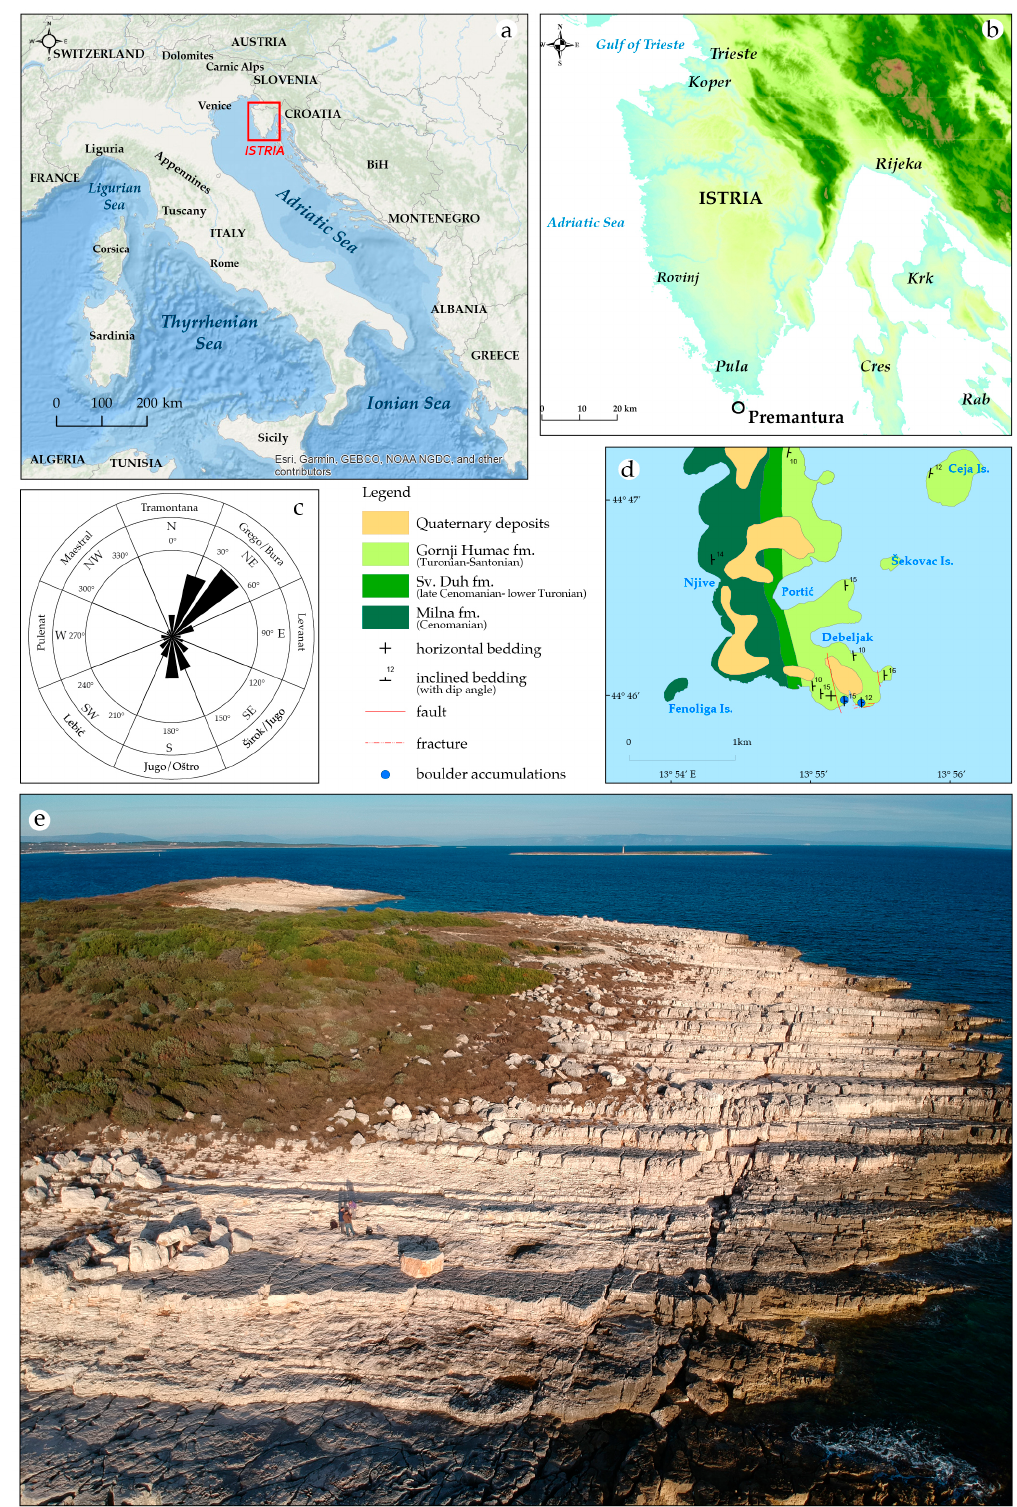
Figure 1. ( a ) Location of the Istrian peninsula, ( b ) location of the Premantura study area, ( c ) Windrose, ( d ) geological map of the South part of the Premantura (Kamenjak) Promontory, and ( e ) oblique view of the study area (Jugo promontory and Cape Kamenjak) where the K8 boulder and clusters of boulders spread along rocky coast are clearly visible.